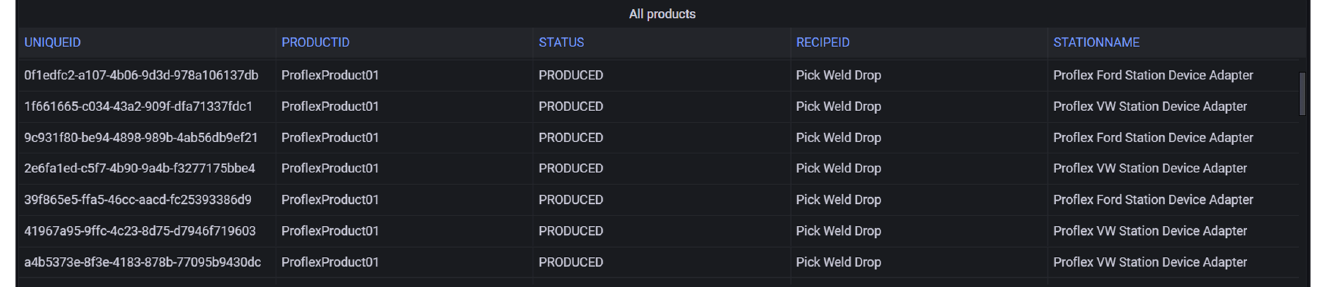
Figure 18. Alert panel.